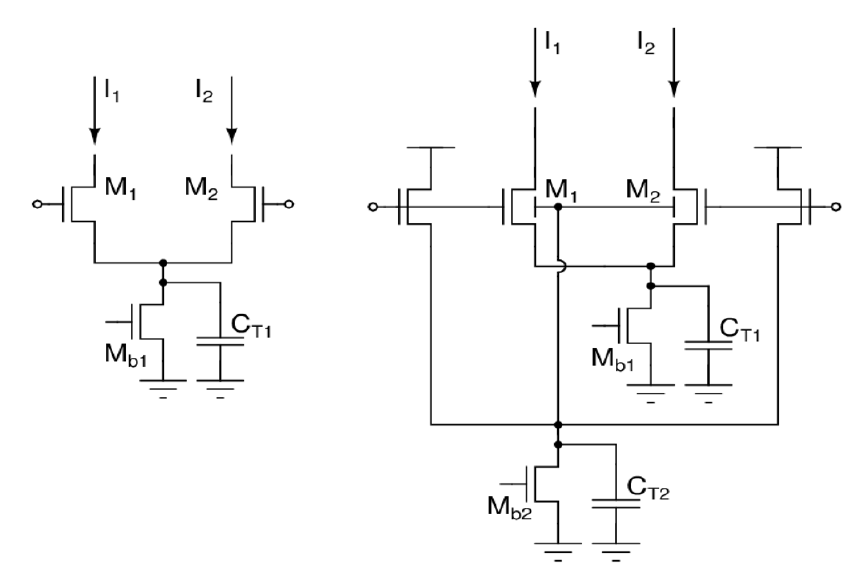
Figure 4. The classic input pair on the left and the source-buffered input pair on the right.